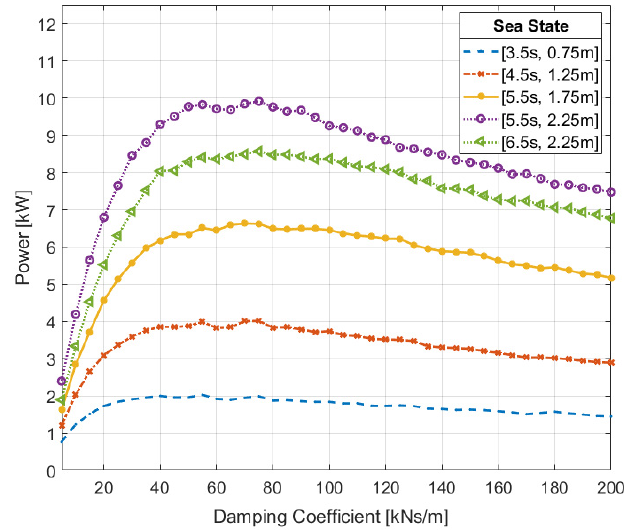
Figure 10. Power profiles vary with the damping coefficient from 5 to 200 kNs/m with an interval of 5 kNs/m (five cases of sea states are selected for comparison).